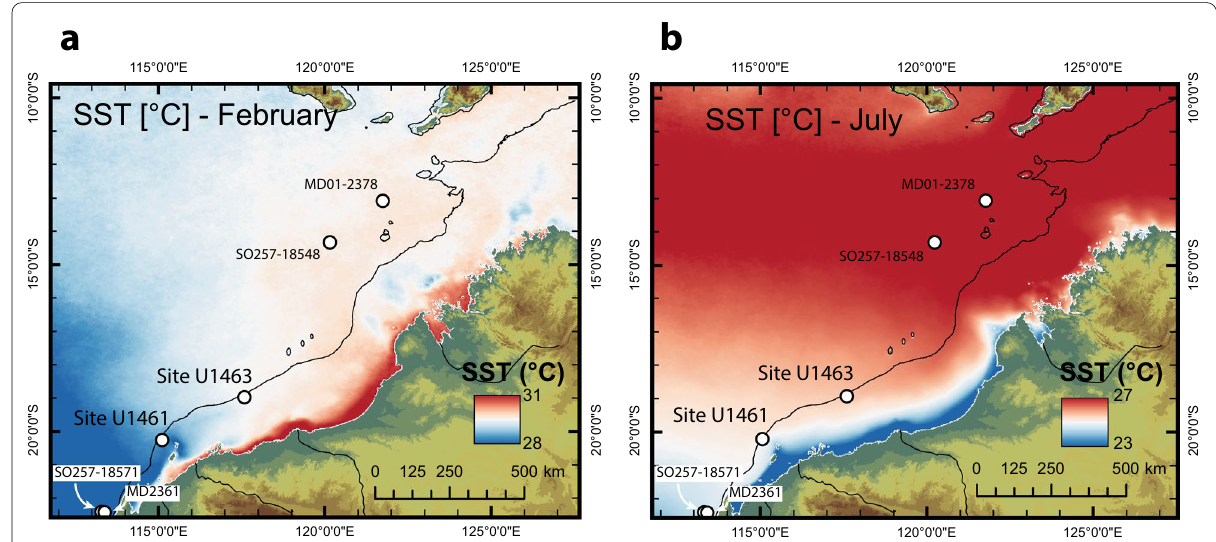
Fig. 1 Modern distribution of water temperature on the NWS. ( a , b ) Maps of the present-day sea surface temperatures (SSTs), as well as the location of important sites offshore of northwestern Australia and in the Timor Sea. Temperature data were acquired from the CSIRO Oceans and Atmosphere database, representing snapshots of the austral summer (February 2015, a ) and austral winter (July 2015, b ) SST distribution (Hobart 2017). The approximate position of the 150 m isobath (black line) delineates the onshore region and shelf